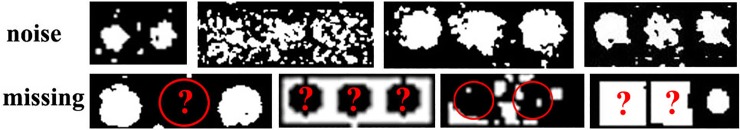
Deficiency examples of different segmentation results.